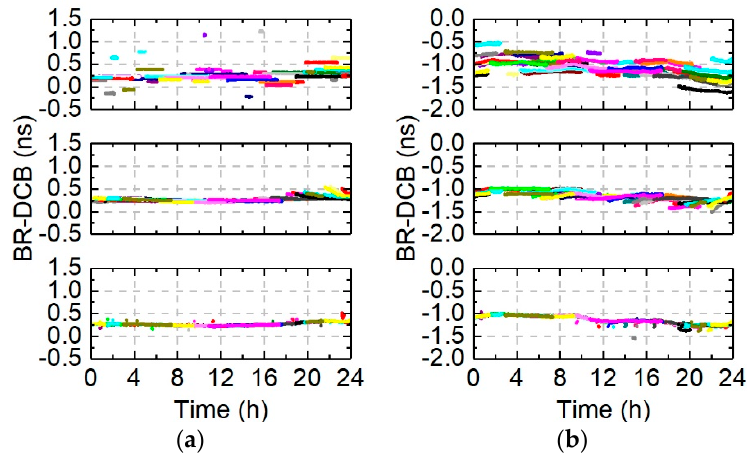
Figure 2. Data processing flowchart of the CCL, PPP-float, and PPP-AR methods.